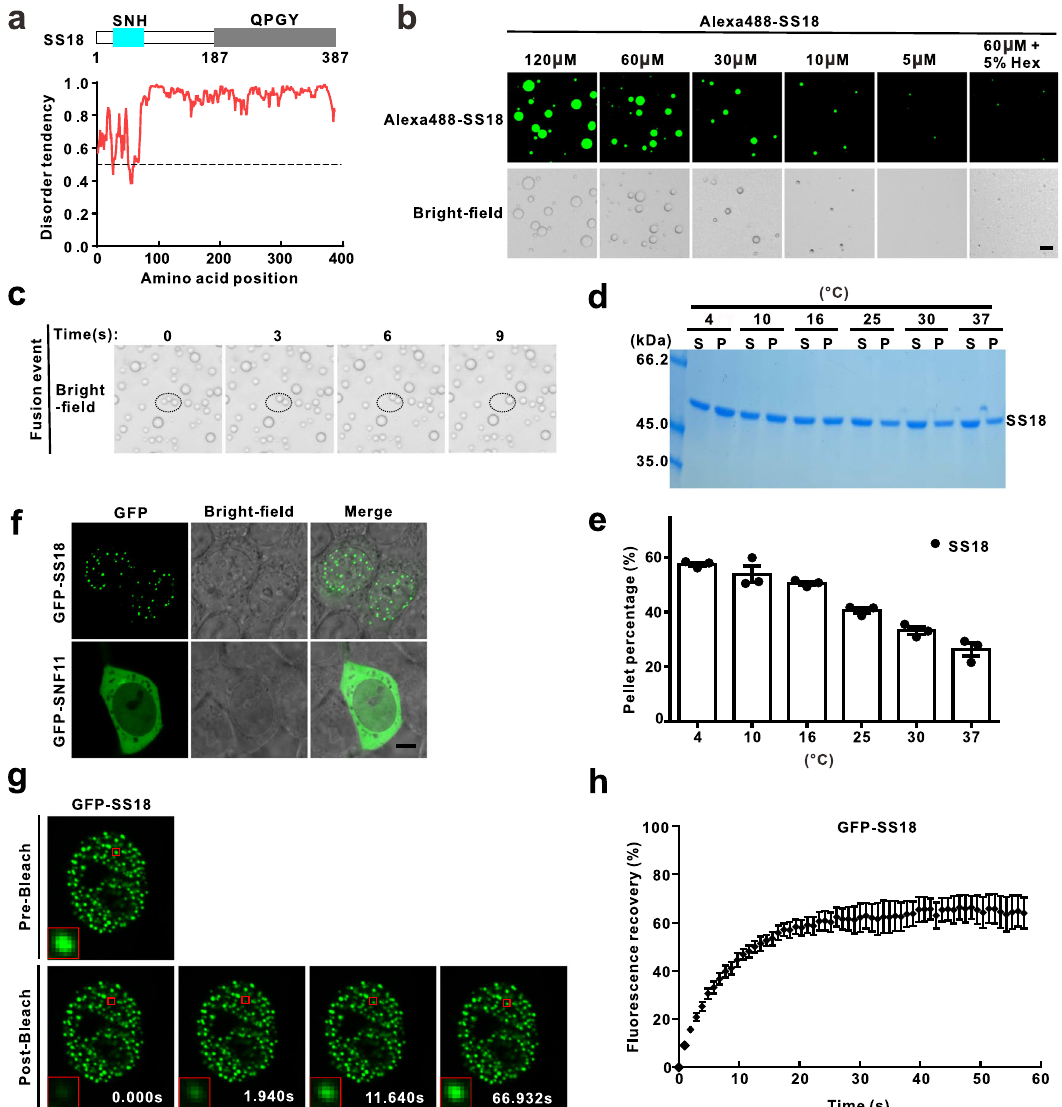
Fig. 3 SS18 undergoes liquid – liquid phase separation (LLPS) in vitro and in vivo. a Analysis of SS18 387 amino acid protein sequence. Known domains SNH and QPGY. Red line predicts intrinsically unstructured regions (IUPred) score for intrinsically disordered tendencies; >0.5 is considered disordered. b Fluorescence and bright- fi eld images of the SS18 droplets at varying protein concentrations. 1,6-hexanediol (Hex, 5%) was added to the SS18 protein (60 µ M) to disrupt droplet formation. Liquid droplets are enriched in Alexa Fluor 488-labeled SS18 (1:100 molar ratio of labeled to unlabeled SS18). This protein labeling ratio was used throughout the study unless otherwise stated. The scale bar indicates 10 μ m. c The small droplets underwent time- dependent dynamic fusion in the buffer comprised 50 mM Tris-HCl pH 7.5 and 150 mM NaCl at room temperature. Representative SDS-PAGE analysis ( d ) and quanti fi cation data e showing the distribution of proteins between aqueous solution/supernatant (S) and condensed liquid droplets/pellet (P) fractions for SS18 protein (30 µ M) at different temperatures. The band intensities of proteins were quanti fi ed with Image J v1.8.0 software. Quantitative data represent results from three independent batches of sedimentation experiments and are plotted as mean ± SEM. f Live-cell imaging (GFP) and concurrent phase-contrast imaging for GFP-SS18 and GFP-SNF11 in HEK293T cells. The scale bar indicates 5 μ m. g Representative time-lapse FRAP images showing that GFP-SS18 signal within the puncta recovered within a few seconds in HeLa cells. Red boxes show the zoomed-in regions. h FRAP recovery curves for six GFP-SS18 puncta from independent six HeLa cells with error bars indicating mean ± SEM. Time 0 refers to the time point of the photobleaching